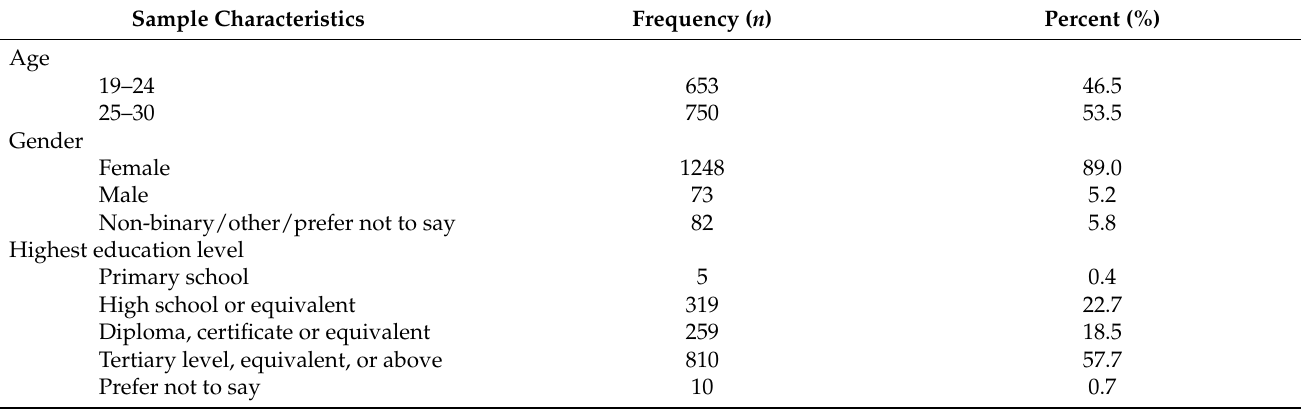
Table 1. Demographic characteristics of the study participants ( n =